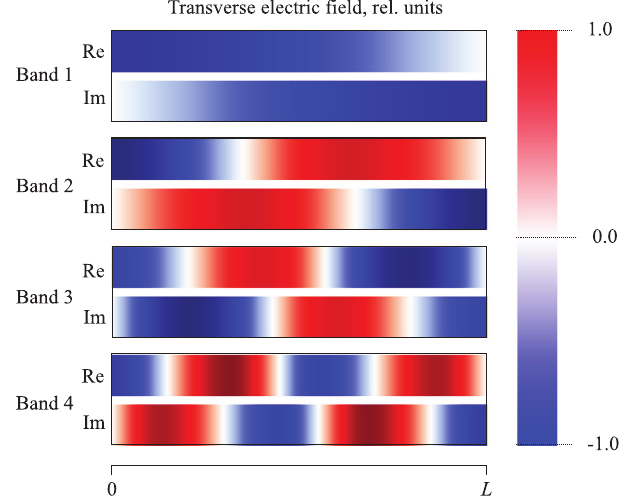
Figure 8. Distribution of the transverse electric field (real and imaginary parts) inside the fractal structure for different propaga- tion bands (in units relative to the field maximum).